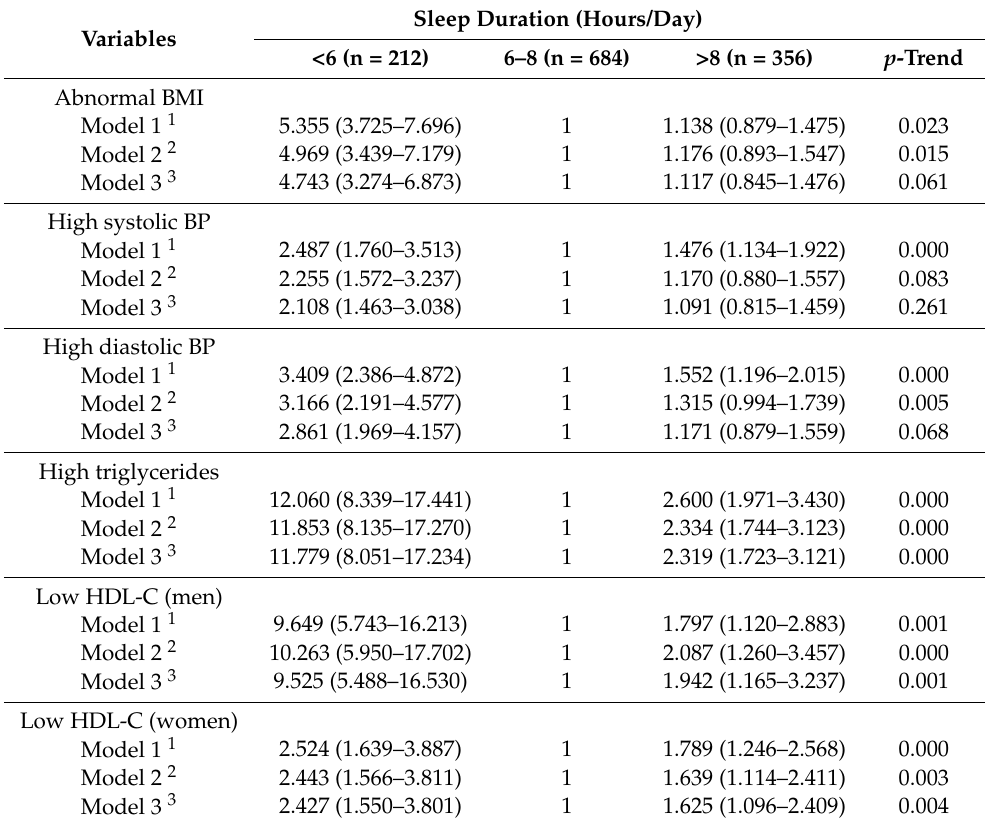
Table 2. Odds ratios (95% CI) of the components of metabolic syndrome and sleep duration (N =